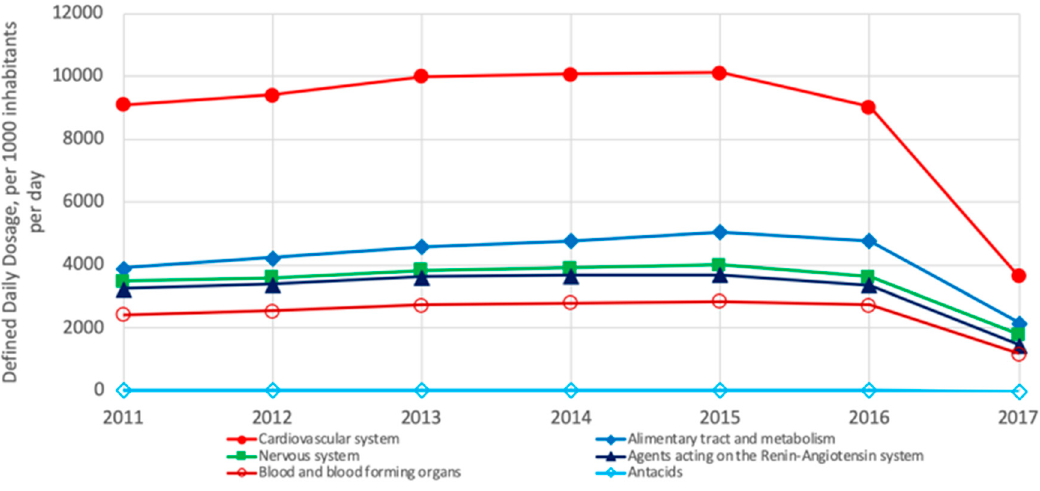
Figure 11. Most consumed pharmaceuticals in OECD European countries from 2011 to 2017 [3]. Drugs for treating the cardiovascular system are most consumed in both regions [3].